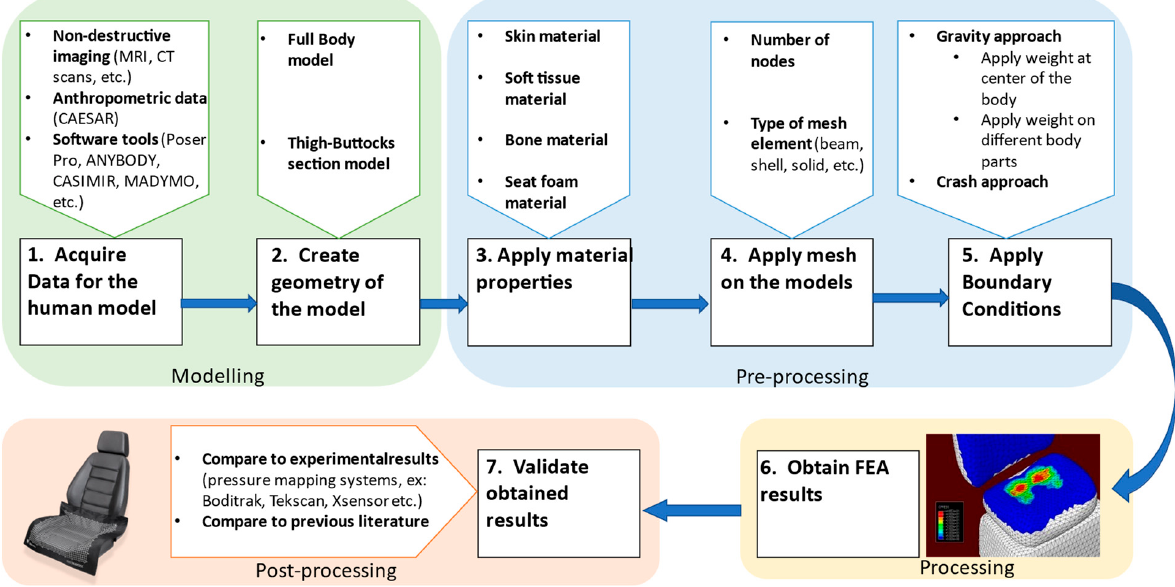
Figure 2. Flow chart showing the steps required to perform FEA simulation of human body–seat interaction [1]. interaction